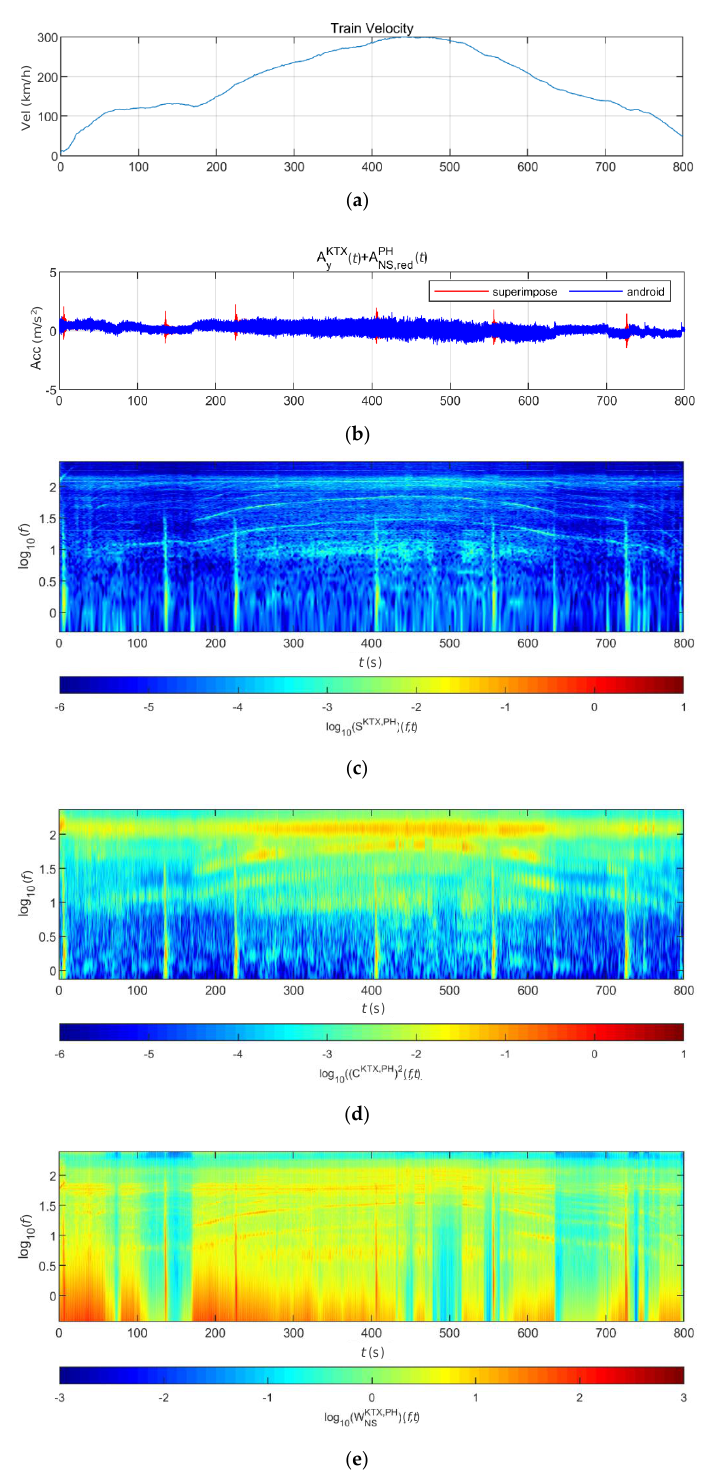
Figure 24. Combination of train data with the Pohang earthquake data (scaled to 1000-year return period): ( a ) velocity; ( b ) lateral acceleration time series; ( c ) STFT; ( d ) WT; ( e ) WVD.